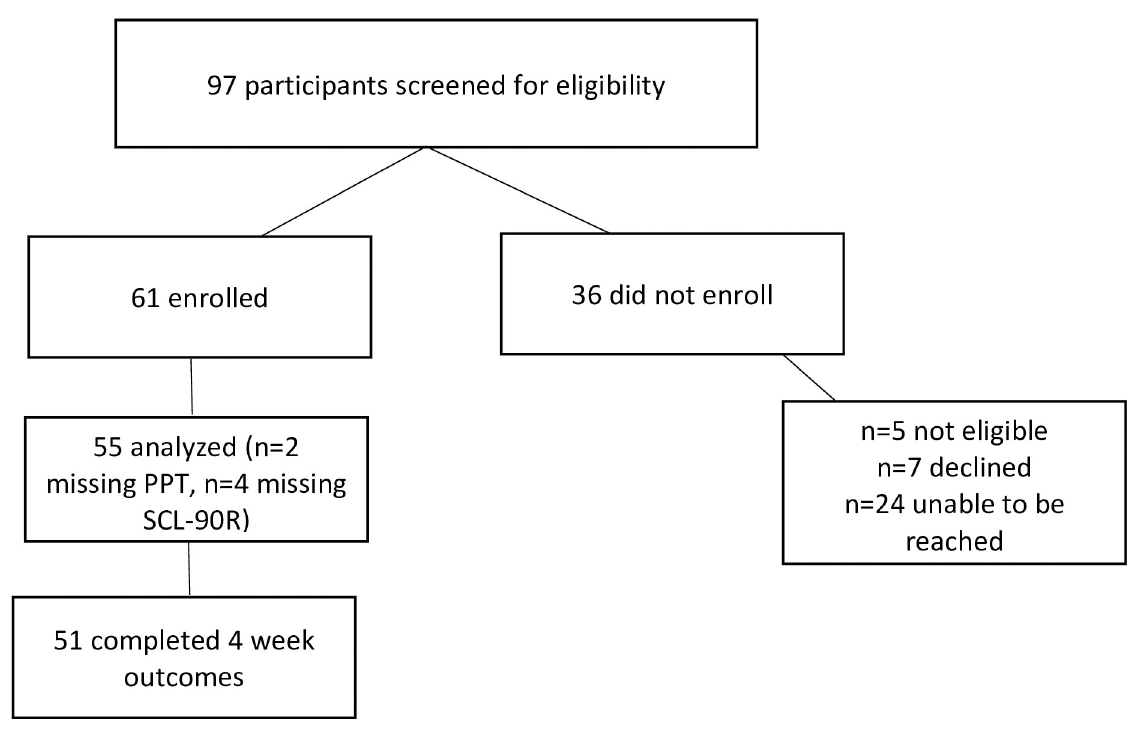
Fig 1. Flow chart of recruitment and